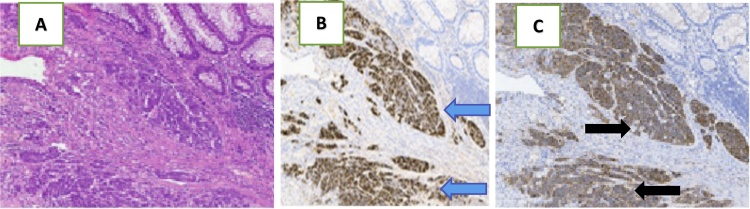
Histopathology slide showing: A) NEC infiltrating the submucosa (HE 4x); B) positive result for Chromogranin A in neoplastic cells (the nuclei are blue and the cytoplasm was brown) (blue arrows); C) positive result for the brown-stained cytoplasm for synaptophysin in neoplastic cells (black arrows).